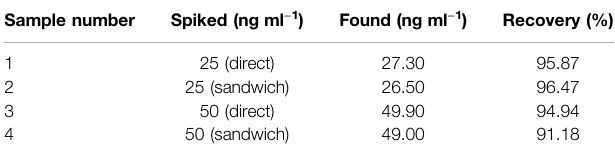
TABLE 2 | Spike and recovery results obtained from the fabricated CRP immunosensor in serum